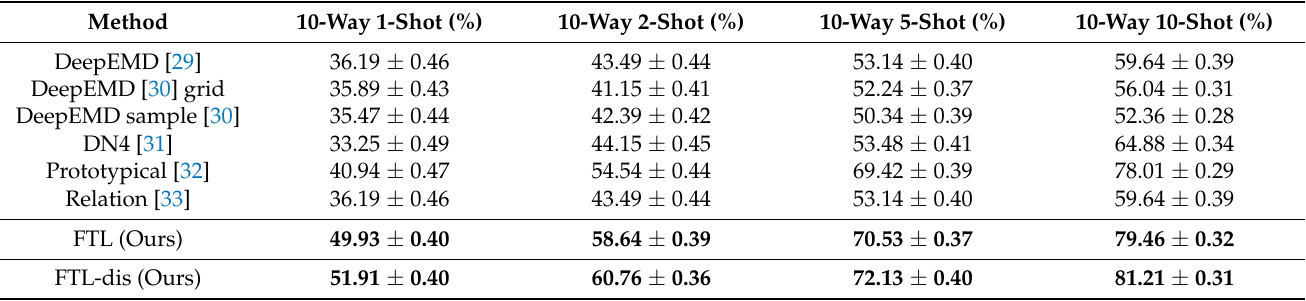
Table 3. Comparative analysis of other few-shot learning